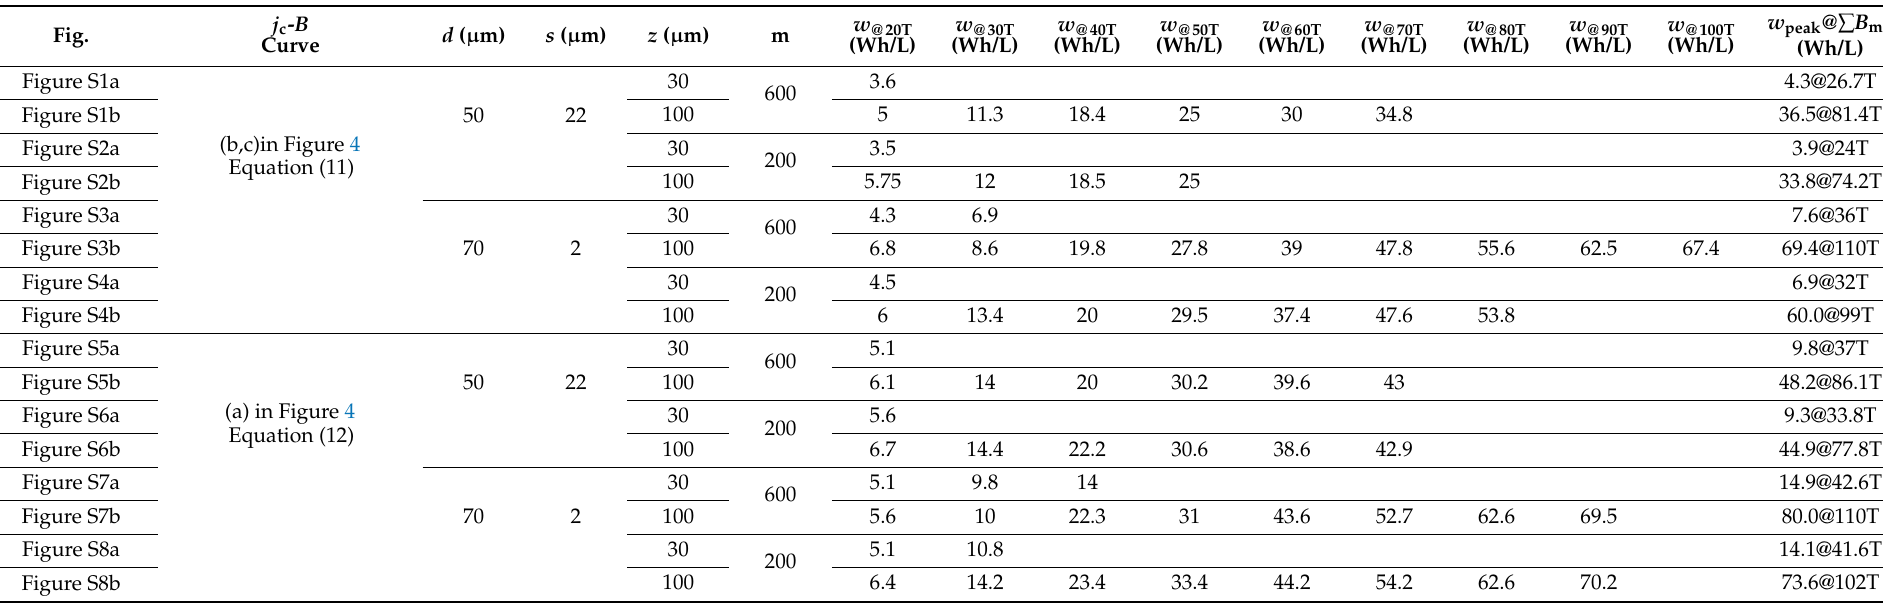
Table 2. Calculated values of w in the unit of Wh/L at the Σ B max of every 10 T increment up to w peak for the different wafer coil design parameters, d, s, z , and the number of stacked wafer coils, m , under the different Σ B max dependences of j c . Expressions such as w @20T indicate w when the Σ B max is 20 T. j c - B